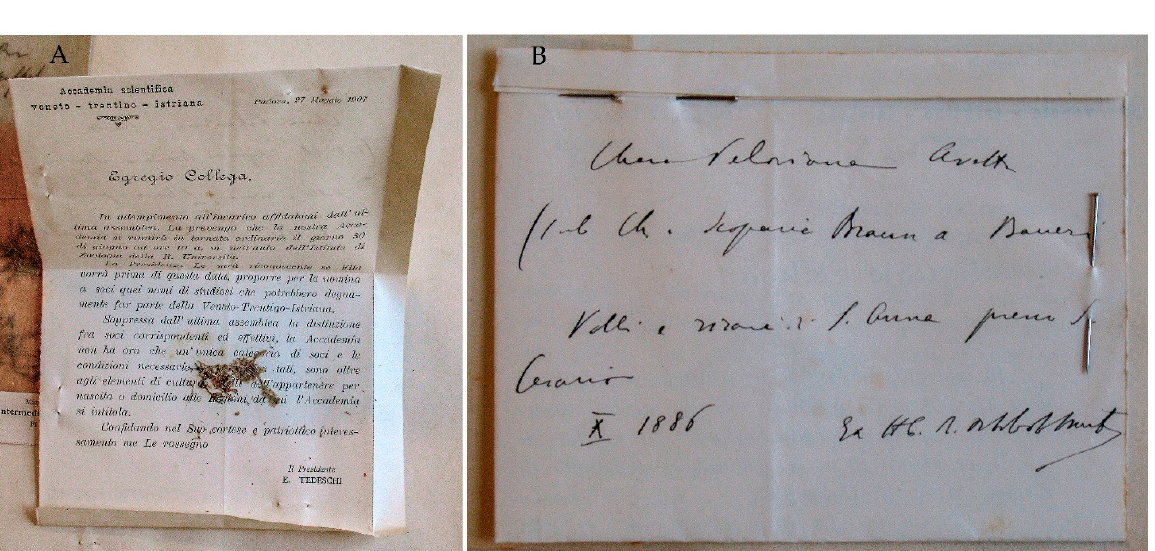
from Nonantola in September 1886 with Ferrari’s label (above) and Formiggini’s revision label (below).